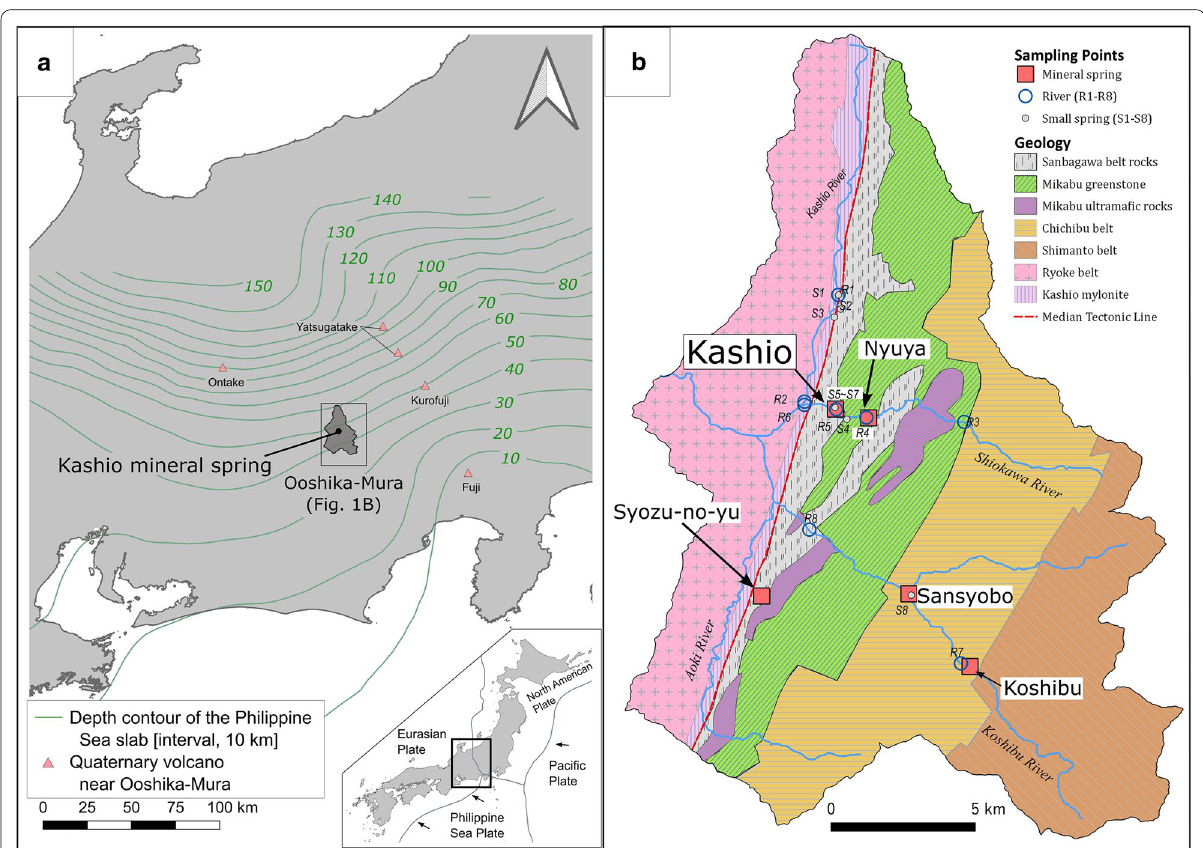
Fig. 1 Location and geological setting of the Kashio mineral spring. a Location of the Ooshika–Mura and the Kashio mineral spring. b Geological setting of Ooshika–Mura and the positions of the sampled water (red squares: mineral springs, blue open circles: river, small gray circles: small springs). Depth contours and geology were modified from GeomapNavi